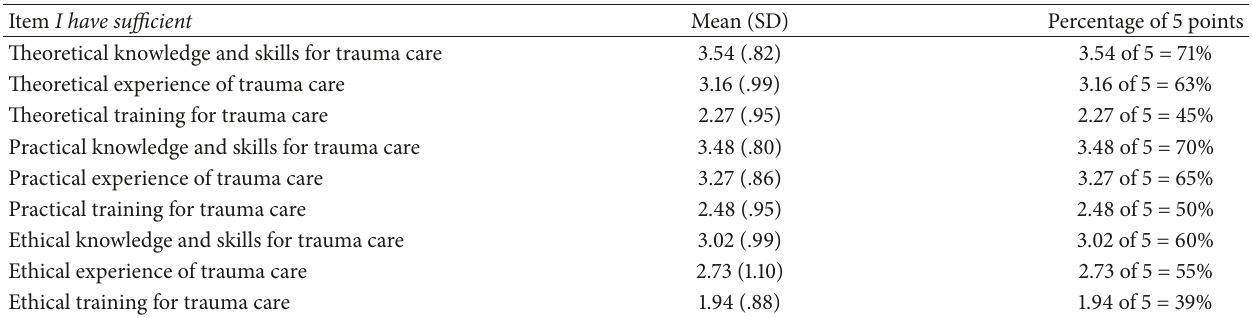
Table 5: Participants self-rated perception on the 5-point Likert scale rated mean in the questionnaire regarding I have sufficient theoretical/practical/ethical knowledge and